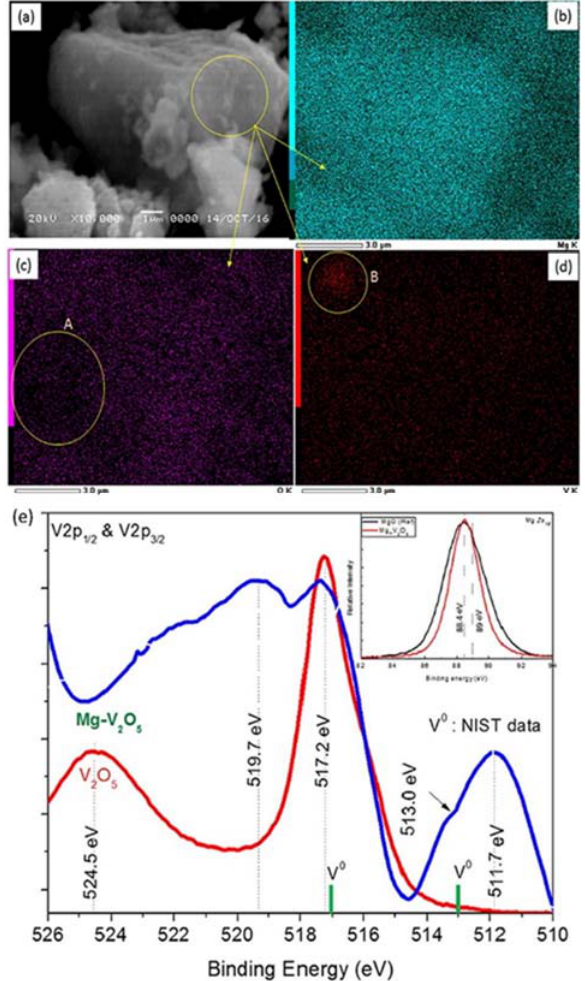
Figure 3. The SEM ‐ EDS analysis of nano ‐ engineered Mg: ( a ) microstructure of the portion of the sample of which EDS mapping has been done ( b ) magnesium mapping, ( c ) oxygen mapping, and ( d ) vanadium mapping. ( e ) The XPS analysis of vanadium in the composite to confirm the chemical state. The inset is the XPS analysis of Mg2 s electron to ratify the chemical of Mg at the surface. Reproduced with permission from [56], Copyright Elsevier, 2017.